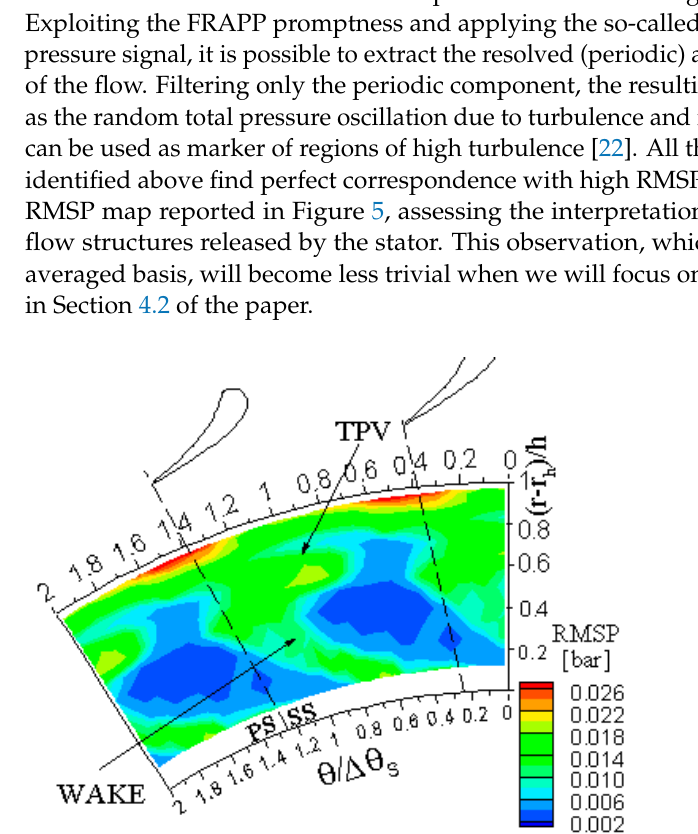
Figure 5. Standard deviation of the absolute total pressure (RMSP) at the stator